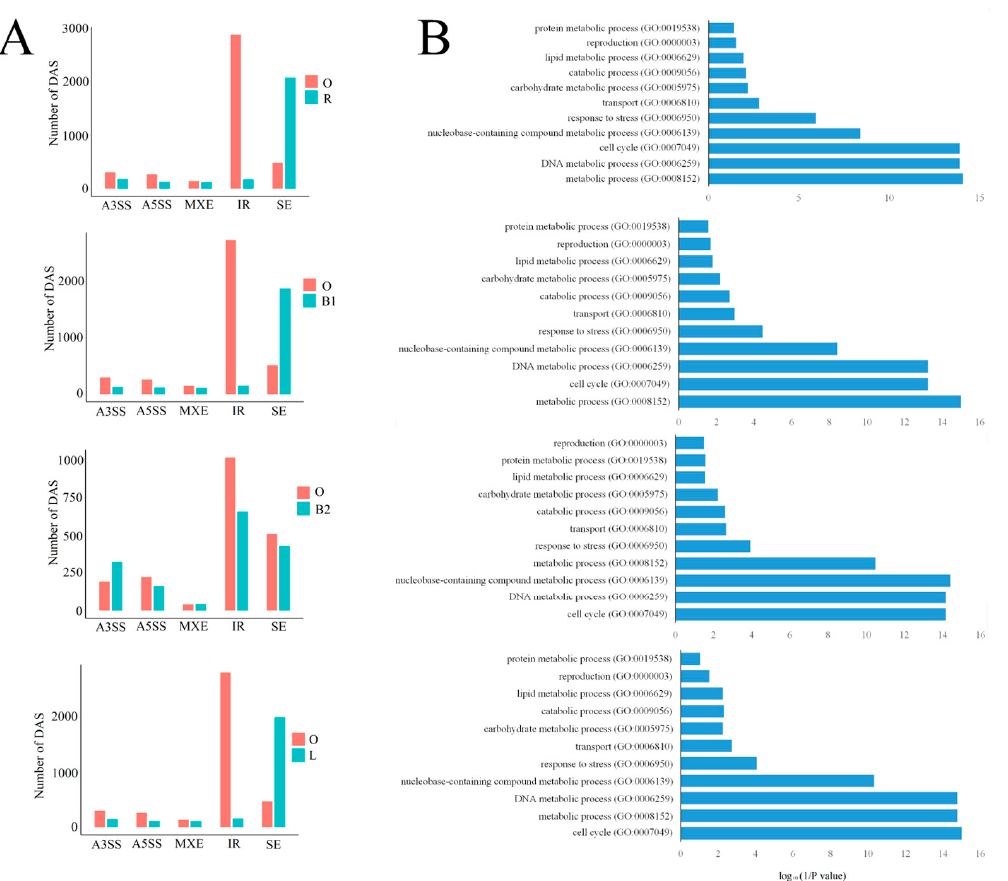
Figure 8. ( A ) The differentially alternative splicing events in the pairwise comparison. Genes derived from alternative 3 ′ acceptor site (A3SS), alternative 5 ′ donor site (A5SS), exon skipping (ES), intron retention (IR), and mutually exclusive exon (MXE) were summarized separately in the rMATs package. ( B ) Functional enrichment (biological process) of differential AS genes.